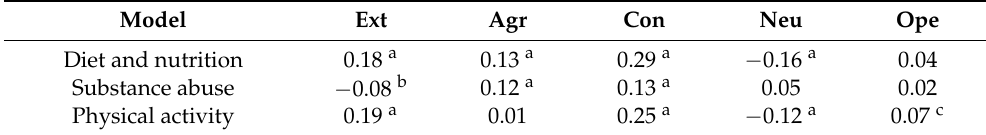
Table 1. Correlation matrix for study